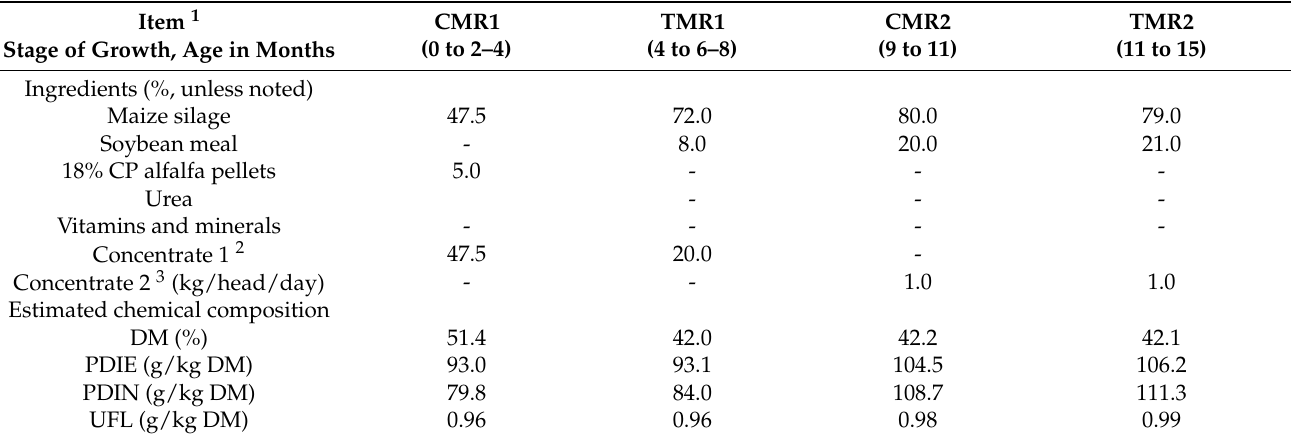
Table 1. Ingredients and chemical composition of the complementary mixed ration (CMR) and total mixed ration (TMR) used during the rearing